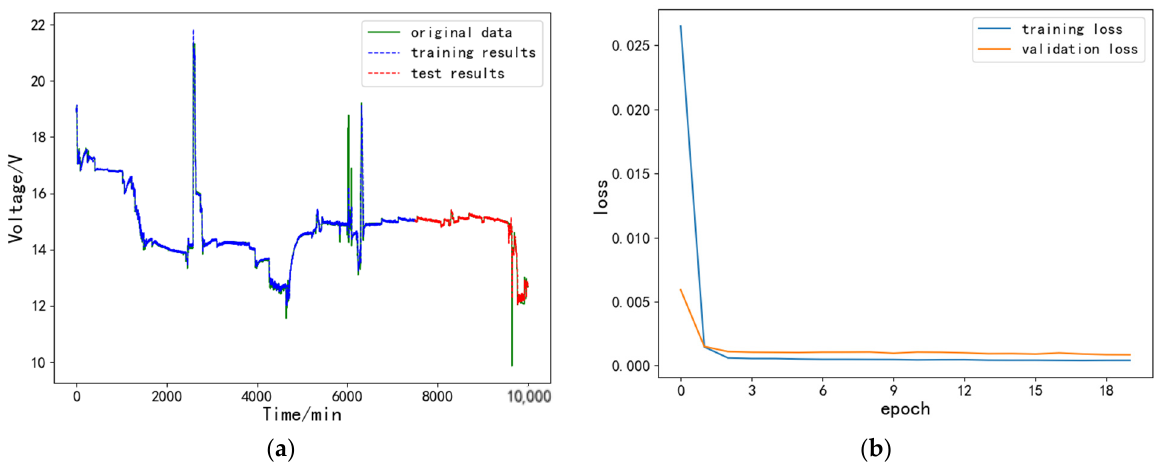
Figure 11. Prediction results of the encoder–decoder LSTM model. ( a ) Model training and prognosis results; ( b ) training-phase loss. Table 2. Calculation of the evaluation criteria for prediction results.